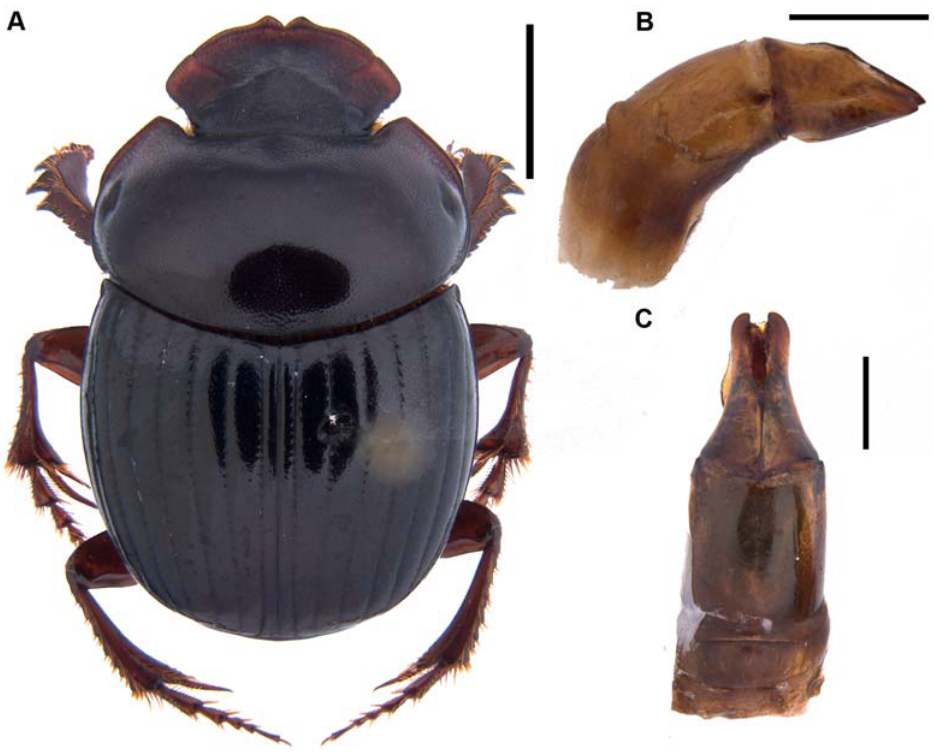
Fig. 5. Canthidium kelleri (Martínez et al ., 1964). A . Dorsal view. B . Lateral view of aedeagus. C . Dorsal view of aedeagus. Scale bars: 1